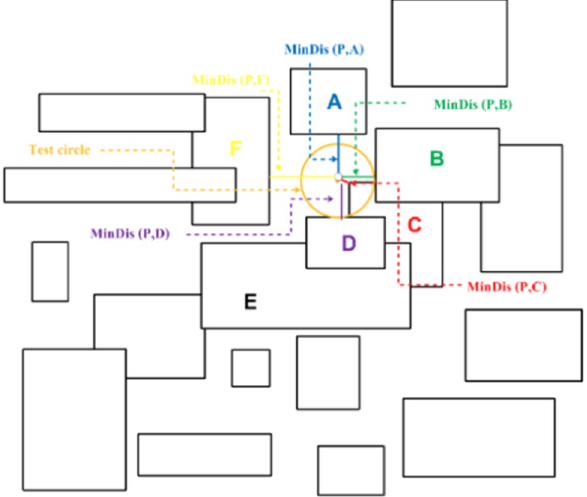
Fig. 9 KNN query operation over the MBRs